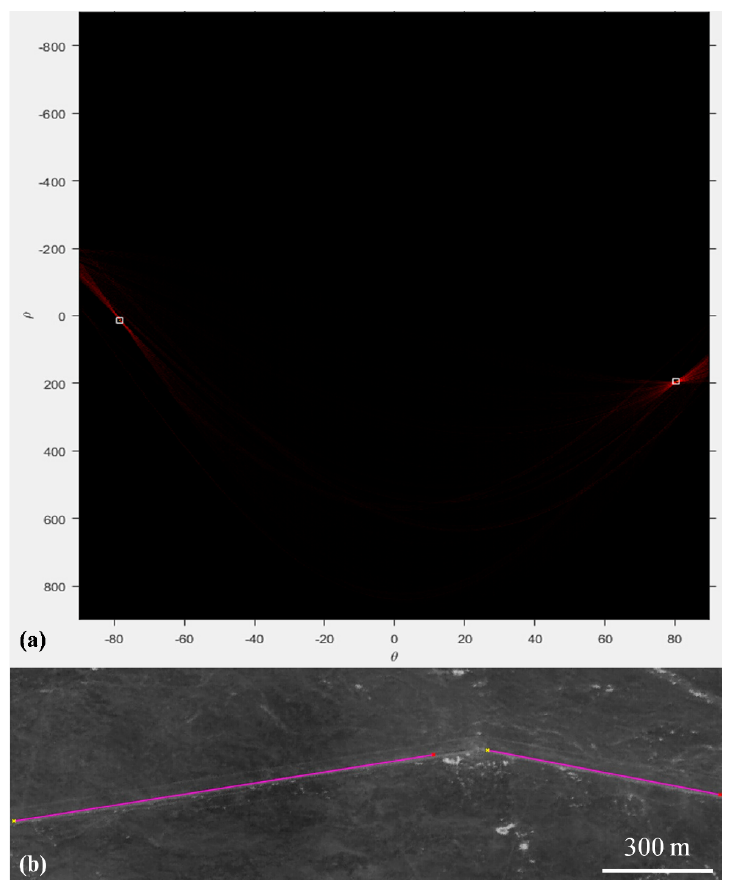
Figure 9. ( a ) The voting results in ( ρ , θ )-parameter space obtained using the image shown in Figure 8d: the two peak points (white squares) indicate that two potential lines were present in the original image. ( b ) The LHT-based line detection results: the magenta lines represent the identified linear traces; the yellow and red points represent the start and end points of the extracted lines, respectively.